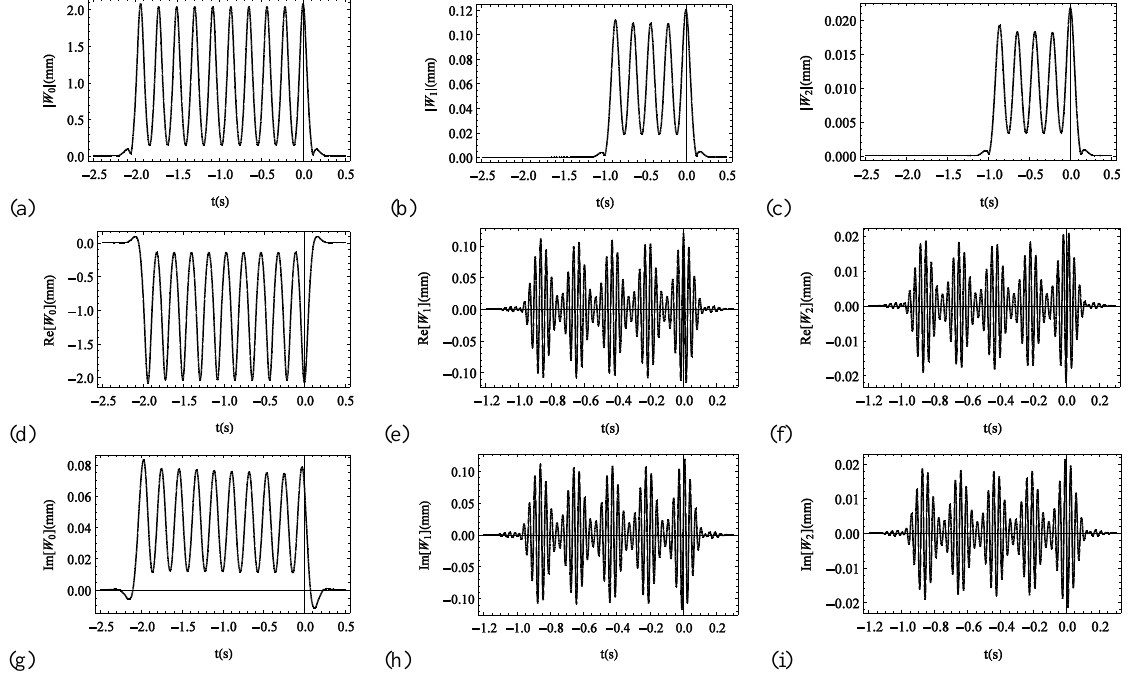
Fig. 3. Terms of Adomian’s decomposition for the vertical displacement: